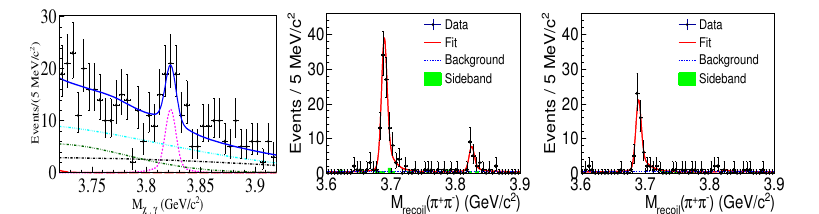
Figure 7. (Left) 2D UML fit projection of the M χ distribution for the simultaneous fit of B ± → c 1 γ ( χ c 1 γ ) K ∓ and B 0 → ( χ c 1 γ ) K 0 decays for M bc > 5 . 27 GeV / c 2 [35]. Simultaneous fit to the M recoil ( π + π − ) S distribution of γχ c 1 events (Middle) and γχ c 1 events (Right) [37]. Dots with error bar are for the data. The solid line denotes the fit results.